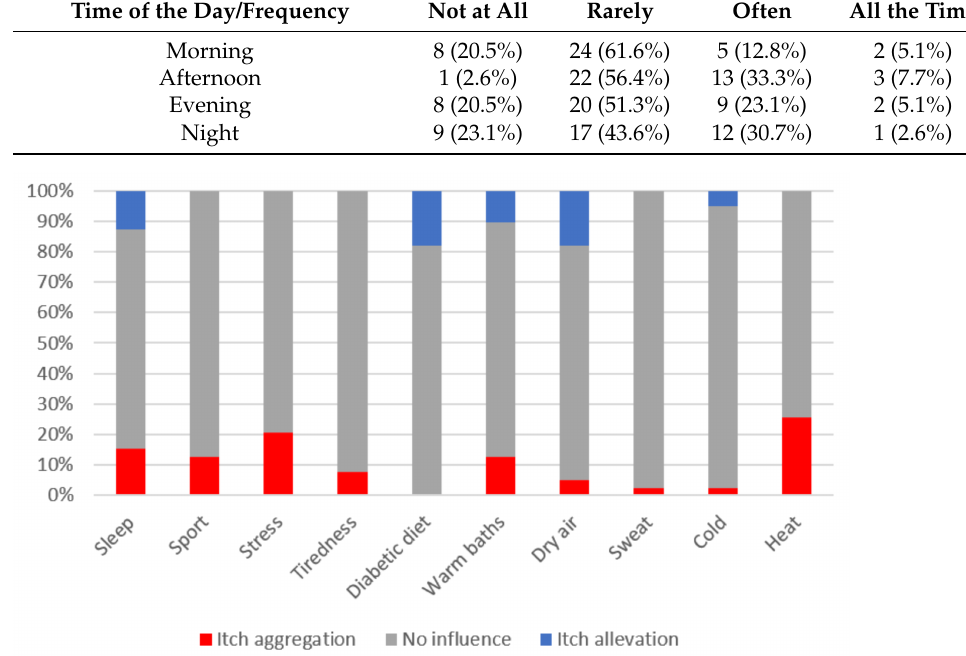
Figure 1. Factors exacerbating and relieving itch in patients with type 2 diabetes